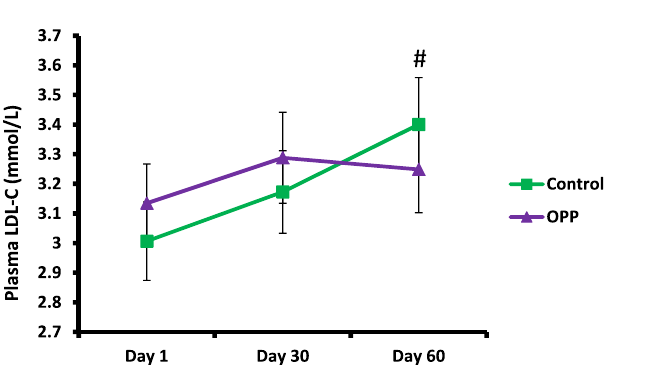
Figure 1. Total cholesterol level in plasma following OPP and control treatments for 60 days. # Time × treatment interaction was significant, p = 0.001 (2-factor repeated measures ANOVA). Based on Wilcoxon signed rank test, TC was significantly lower for OPP treatment compared to control treatment (at day 60), p = 0.025. However, following Bonferroni correction, no significant difference of total cholesterol level was found between OPP and control treatments at day 1, 30 and 60.